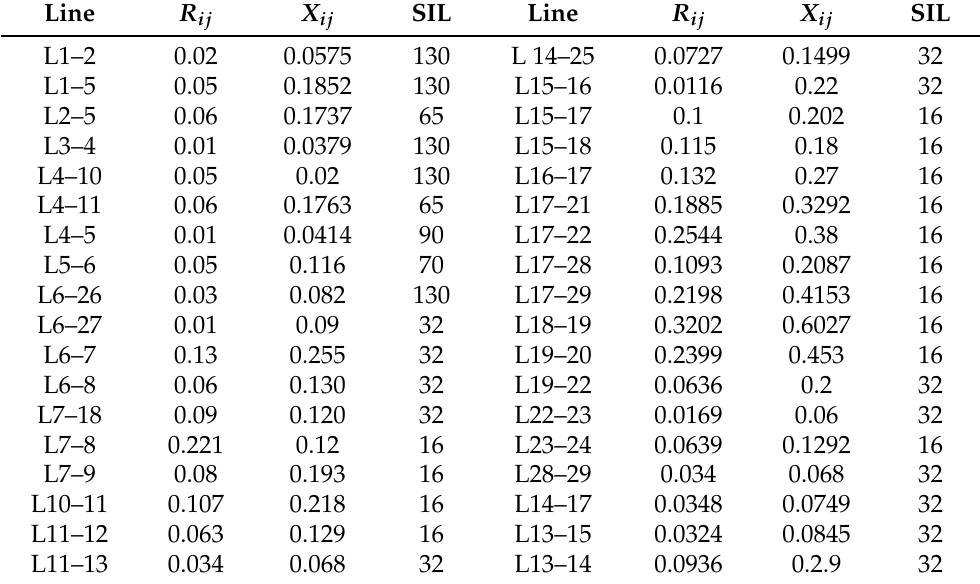
Table 2. Transmission line